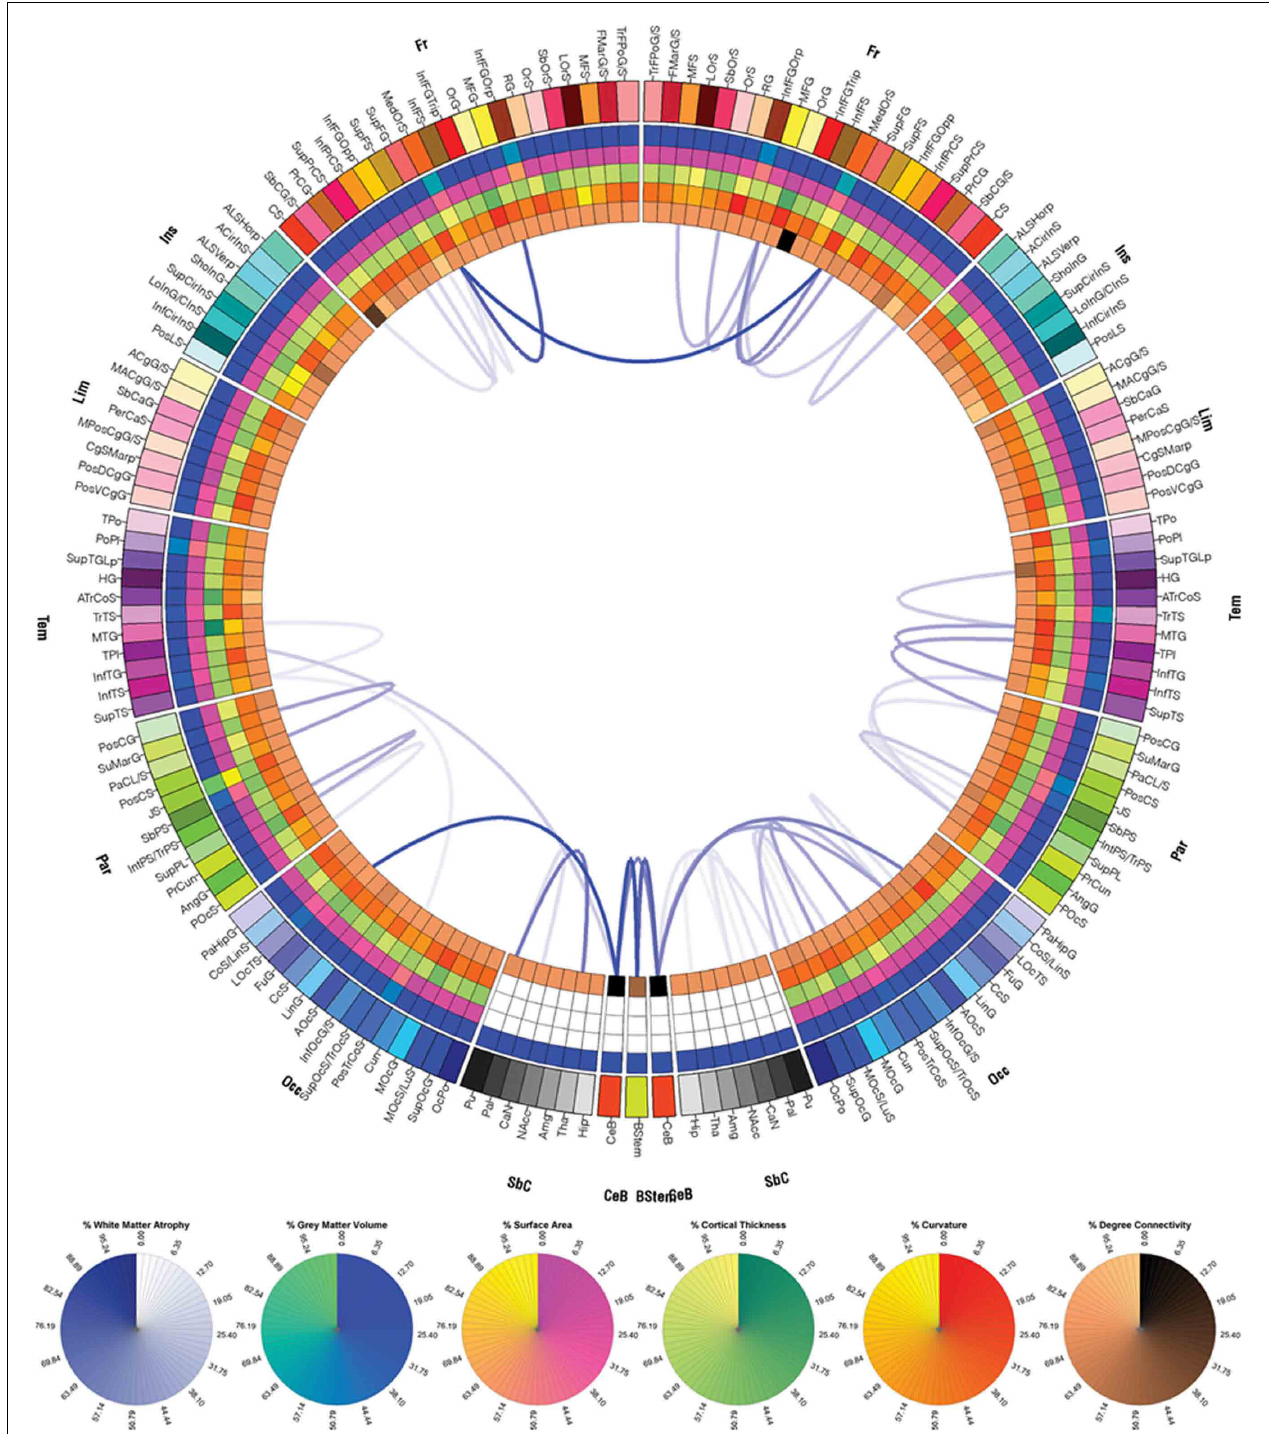
FIGURE 9 |As in Figure 7, for patient 3.